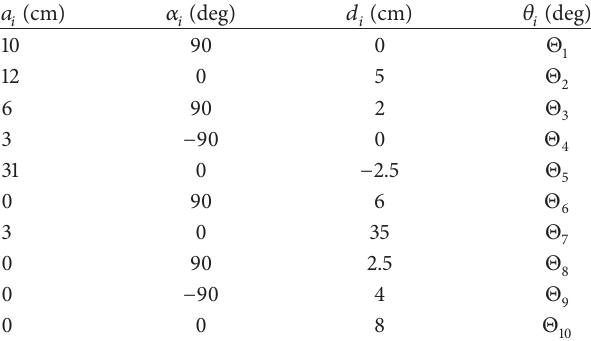
Table 2: D-H parameter of